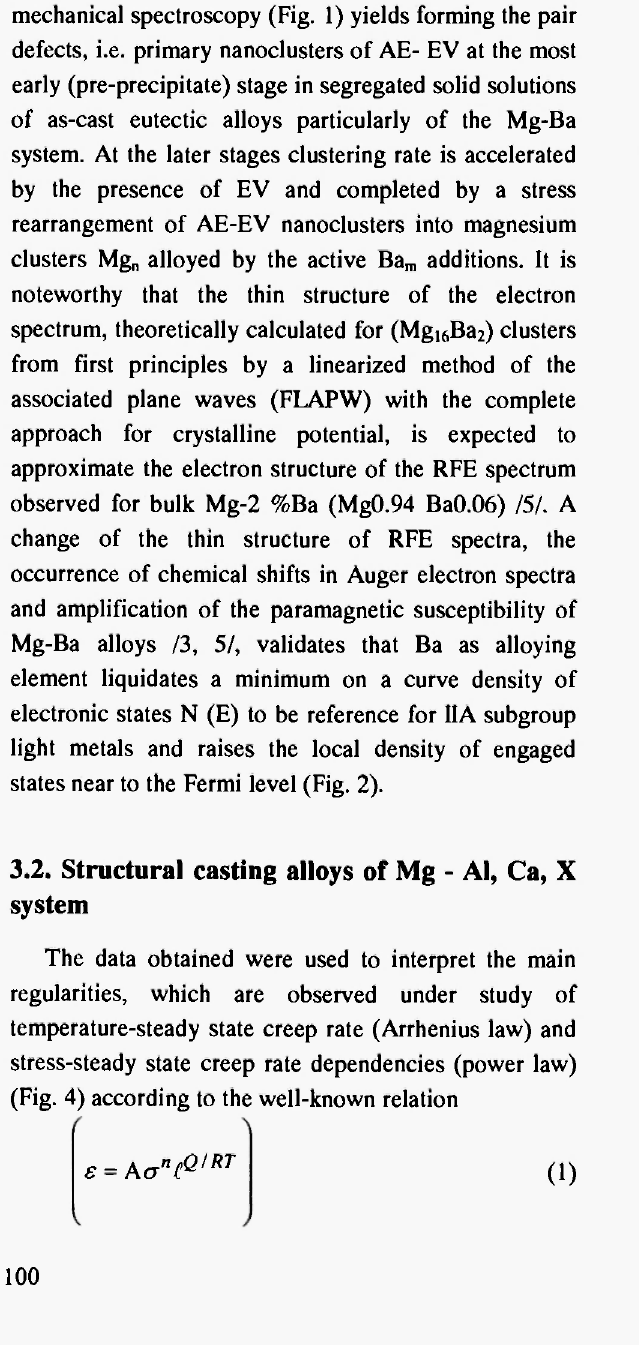
Fig. 4: (a) Arrhenius plot in the power law creep regime and (b) stress dependence of the steady state strain rate (with stress exponent n) for commercial cast Mg AZ91D (1) and cast alloy of Mg-Al-Ca, X system with cluster sites- forming structure